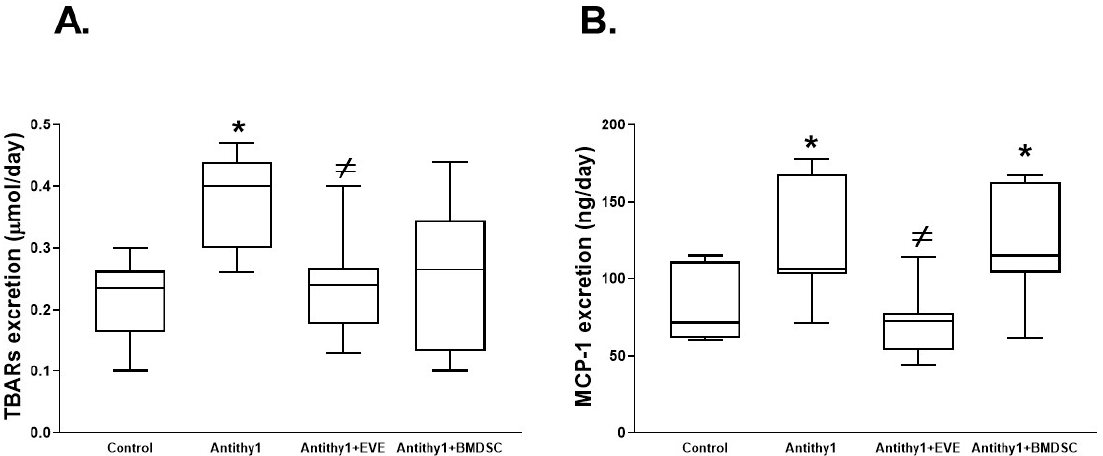
Figure 5. Urinary TBARs excretion ( A ) as a marker of oxidative stress and MCP-1 excretion as a marker of inflammation ( B ) in control and anti-Thy1 rats with or without everolimus or BMDSC treatment. Only everolimus treatment significantly reduced the elevation in urinary TBARs and MCP-1 excretion levels in anti-Thy1-injected rats (n = 6–8, * vs. control and ≠ vs. anti-Thy1-injected rats).